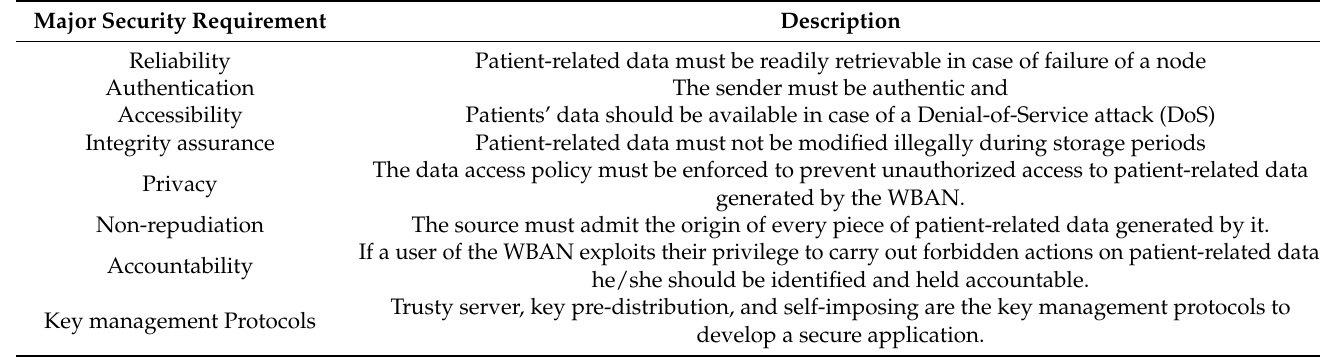
Table 6. Security